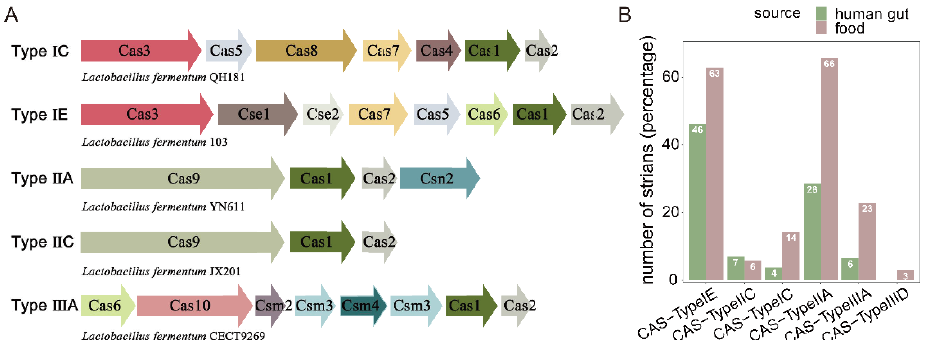
Figure 7. Clustered regularly interspaced short palindromic repeats (CRISPRs)/Cas system in L. fermentum . ( A ) Represent systems (Type IC, Type IE, Type IIA, Type IIC and Type IIIA) of Cas genes were listed; ( B ) distribution of CRISPR–Cas systems among strains of L. fermentum isolated from human gut and food.